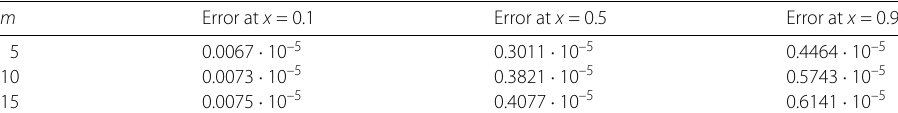
Table 2 Error estimates of ( p , q )-Lupa¸s–Schurer operators for various values of x m